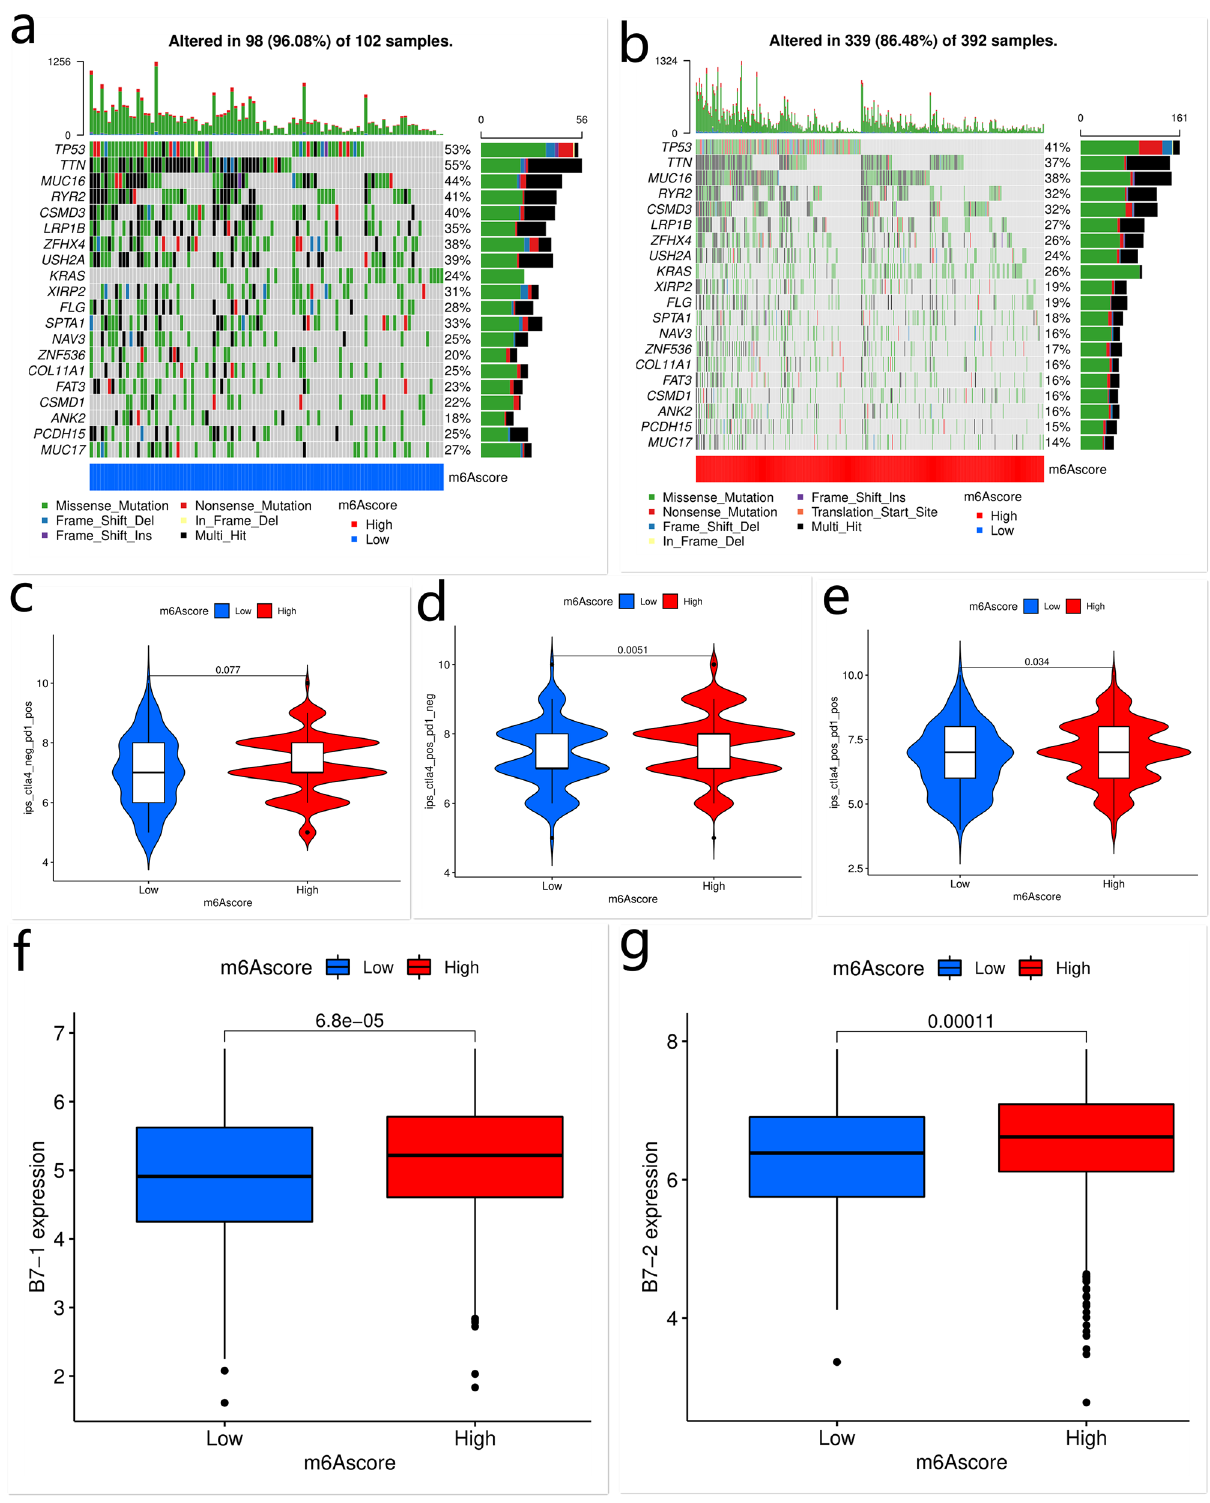
Figure 6. The frequency of all mutated gene and immunotherapeutic response of patients with low or high m 6 Ascore. The frequency of all mutated genes in LUAD in the low and high m 6 Ascore groups ( a , b ). The effectiveness of anti-CTLA4 and/or anti-PD-1 immunotherapies in the low and high m 6 Ascore groups. “ctla4- neg-pd1-pos” indicates patients treated with anti-PD-1 therapy alone; “ctla4-pos-pd1-neg” indicates patients treated with anti-CTLA4 therapy alone; “ctla4-pos-pd1-pos” indicates patients treated with both anti-CTLA4 and anti-PD-1 therapies ( c – e ). The expressions of B7-1 and B7-2 in the low and high m 6 Ascore groups ( f , g ). This figure is created using the R (version 4.0.3) (https:// www.r- proje ct.